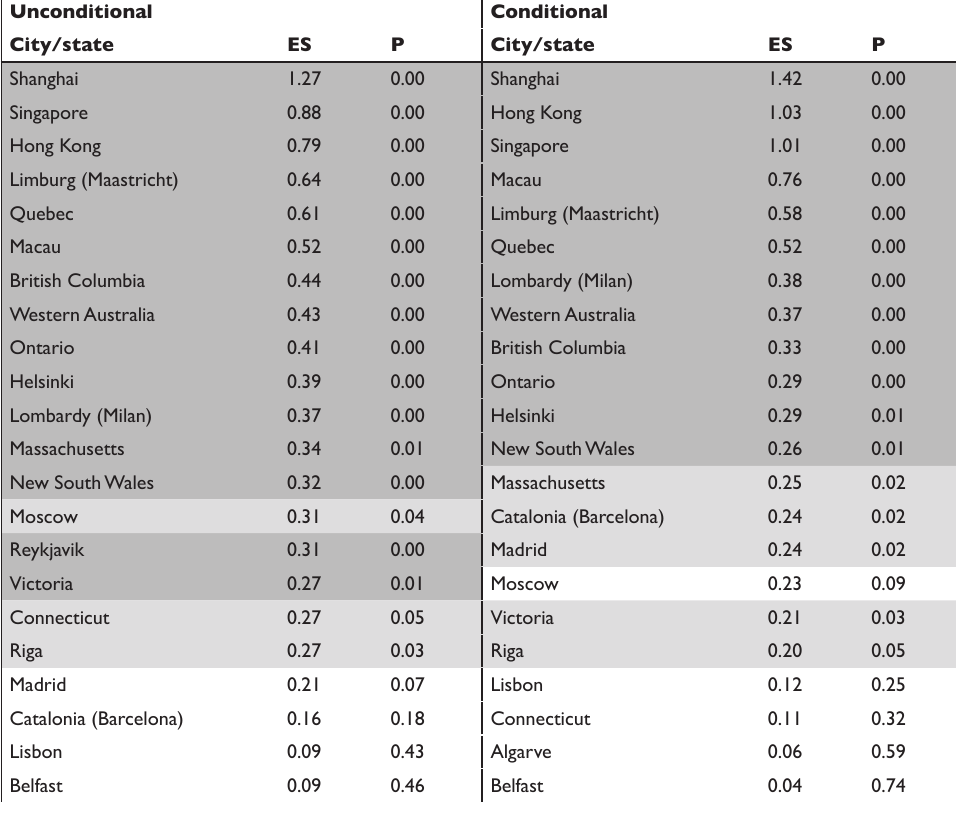
Table 5: London’spositioninthepooledPISA2009and2012PISAmathematicsrankings:beforeand